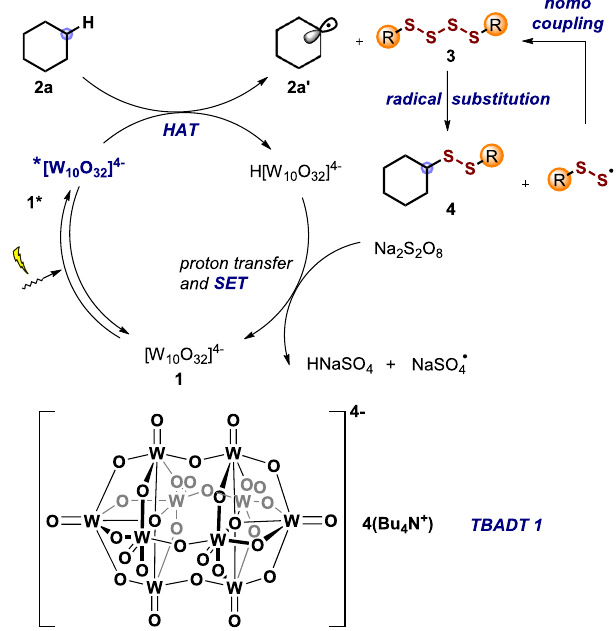
Fig. 3 Reaction design. The suggested mechanism for direct C-H disulfuration via decatungstate photocatalysis.